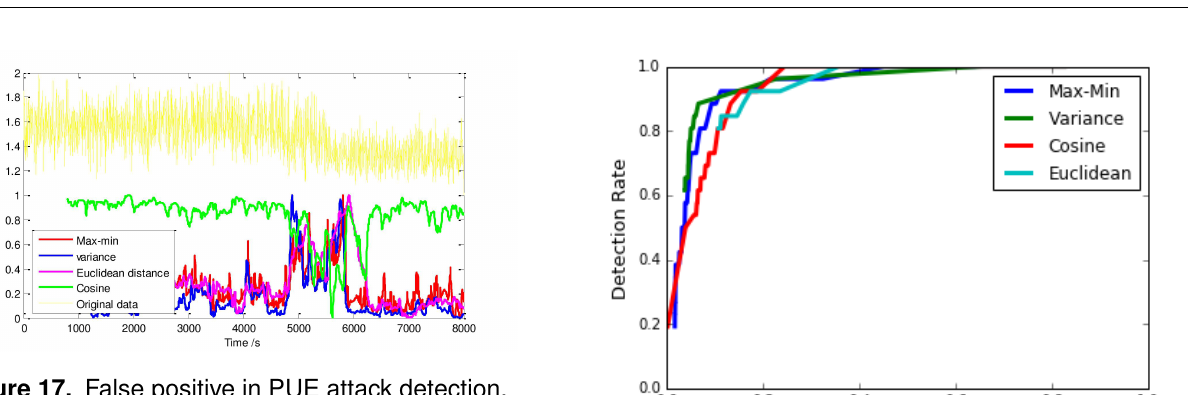
Figure 17. False positive in PUE attack detection.